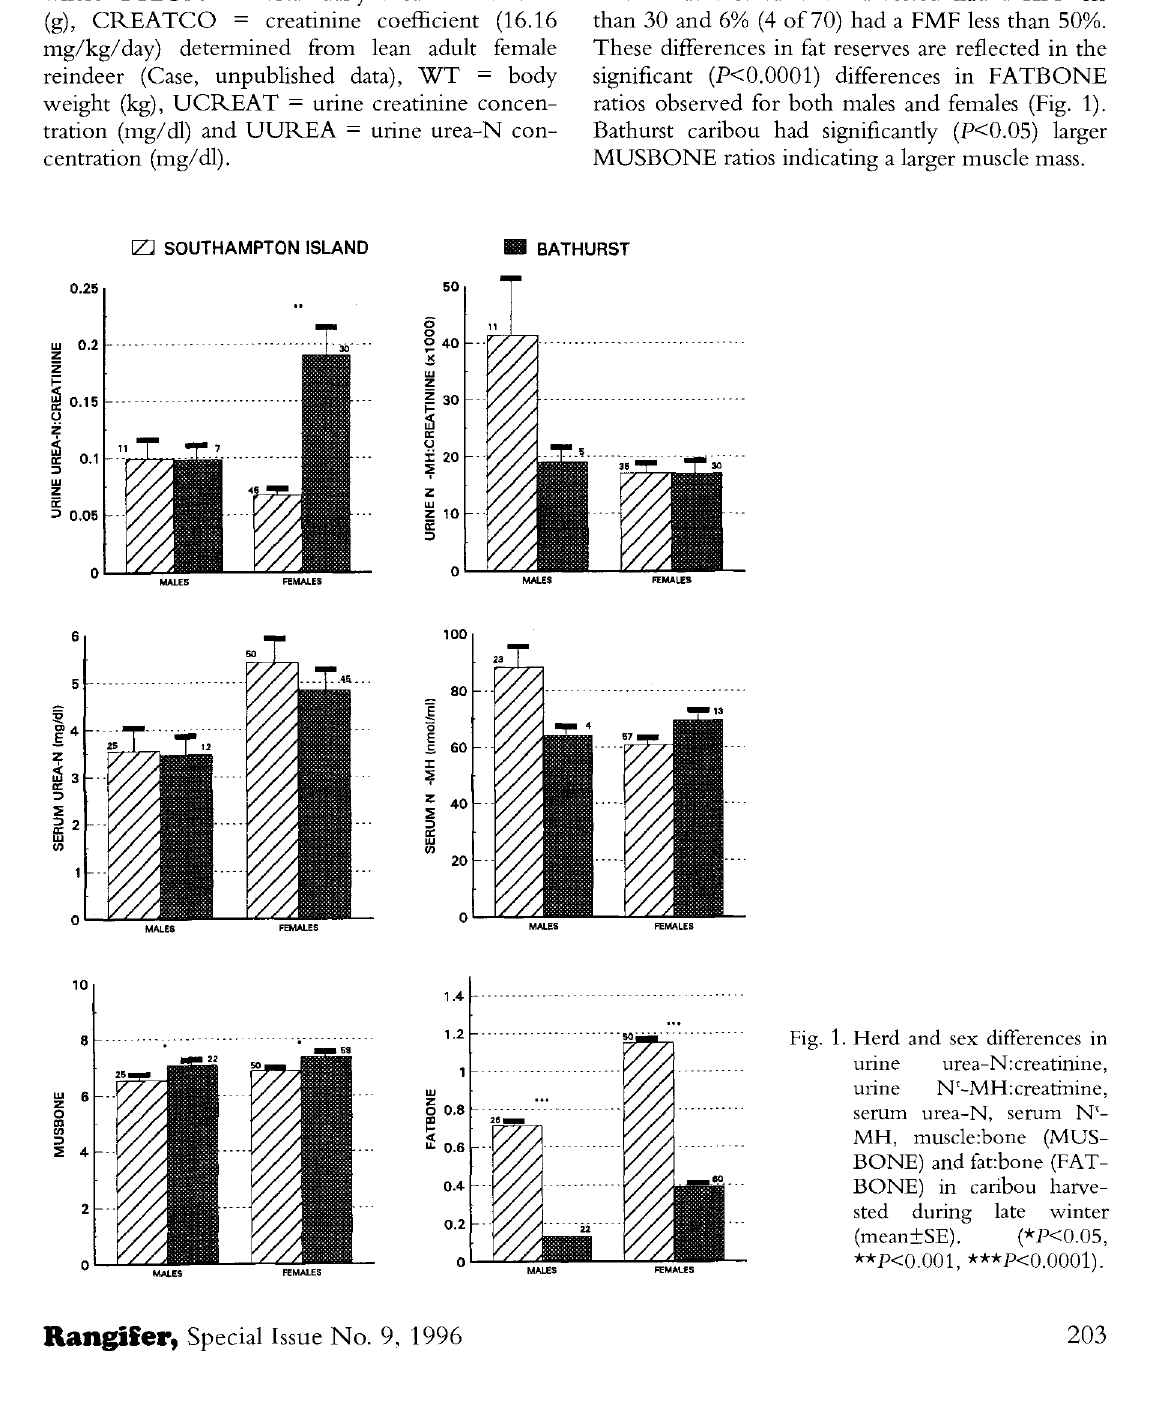
Fig. 1. Herd and sex differences in urine urea-Nxreatinine, urine N*-MH:creatmine, serum urea-N, serum N '- M H, muscle:bone (MUS BONE) and fat:bone (FAT- BONE) in caribou harve sted during late winter